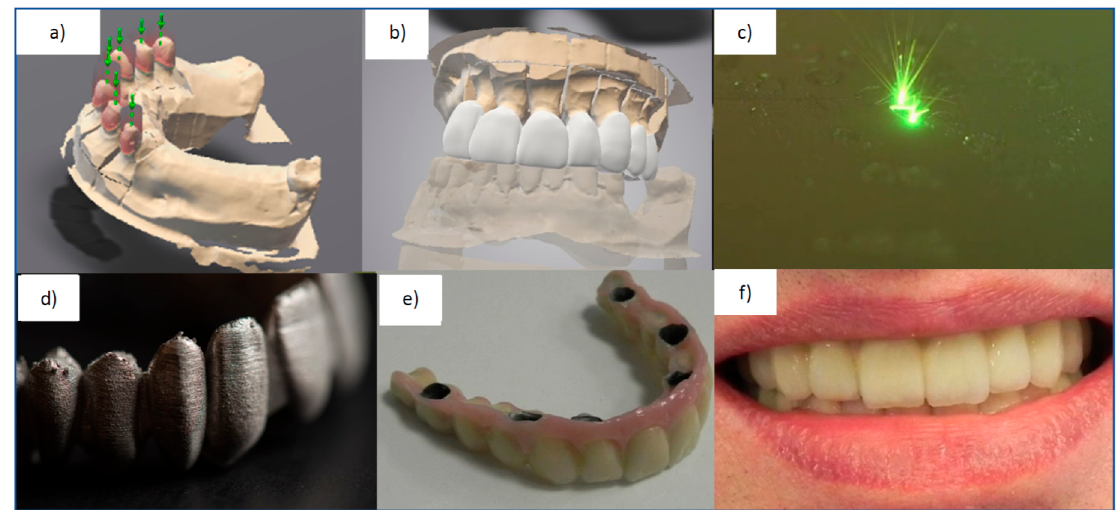
Figure 25. The examples of different stages of design and manufacturing by the selective laser sintering SLS of dental bridges from Co-Cr powders: ( a ) virtual tooth model and the verification of the parallelism of the pillars; ( b ) the finished foundation design for transferring from CAD to CAM; ( c ) selective laser sintering process photo; ( d ) the finished element after SLS; ( e ) the prosthetic restoration veneered with porcelain; ( f ) the bridge installed in the patient mouth.